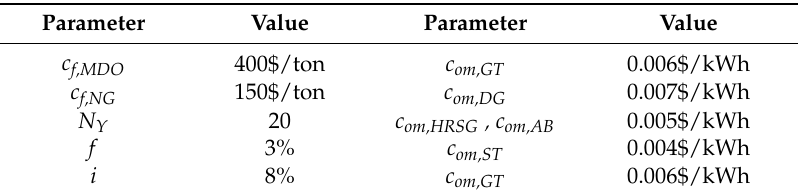
Table 4. Values of economic parameters.